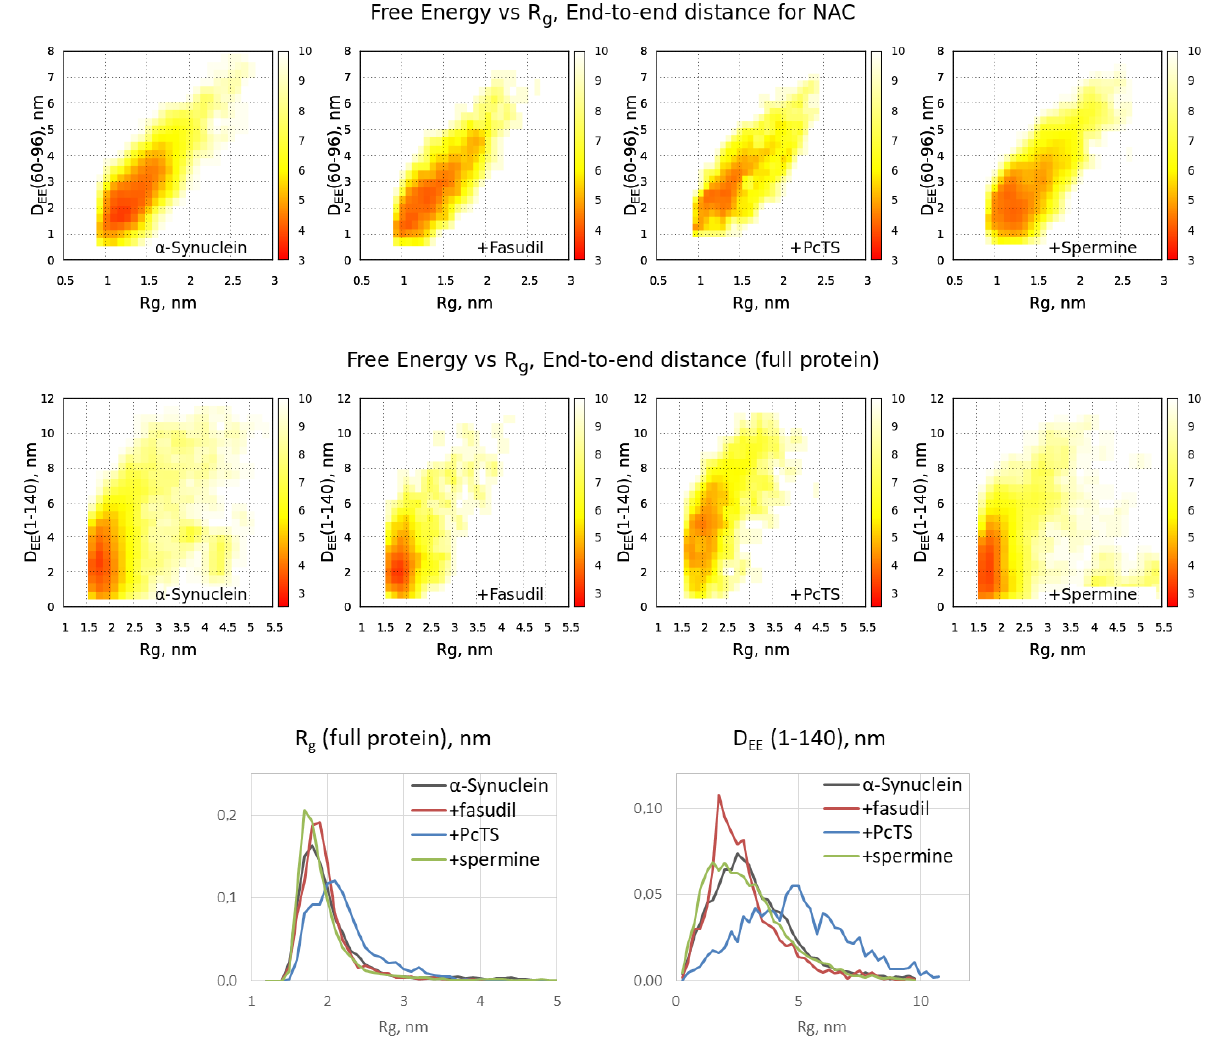
Figure 3. Free energy distributions for conformational ensembles of alpha-synuclein in a free form and when bound with ligands: NAC domain ( top ) and full protein chain ( middle ) as well as Rg and end-to-end distance distributions for the ensembles ( bottom ).